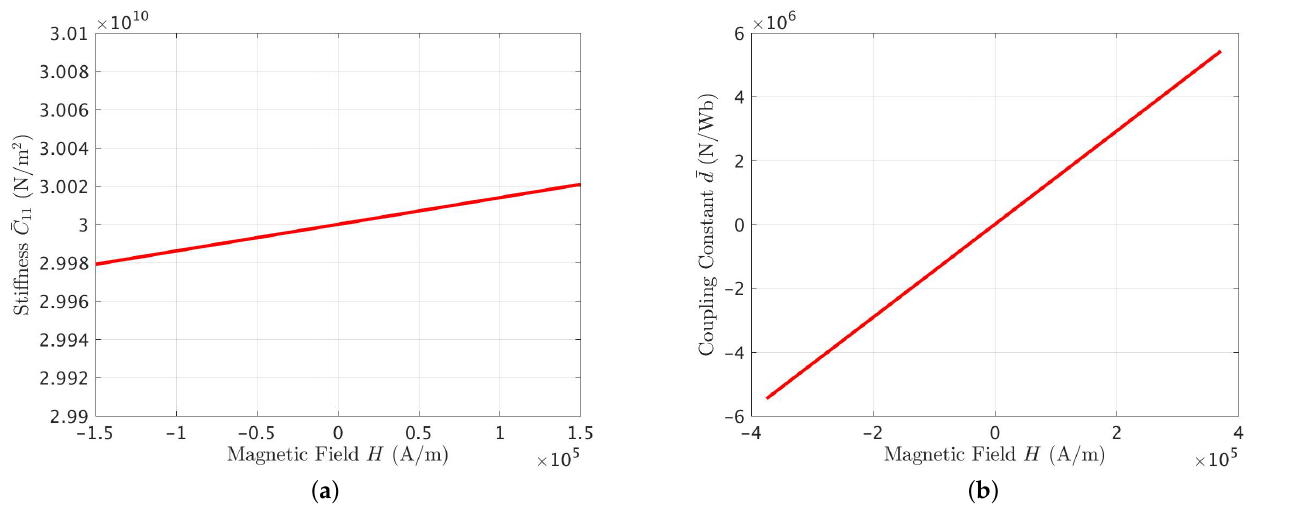
Figure 3. Effective stiffness c 1 and magnetic flux density–stress coupling constant d 1 under the action of magnetic field H 0 .